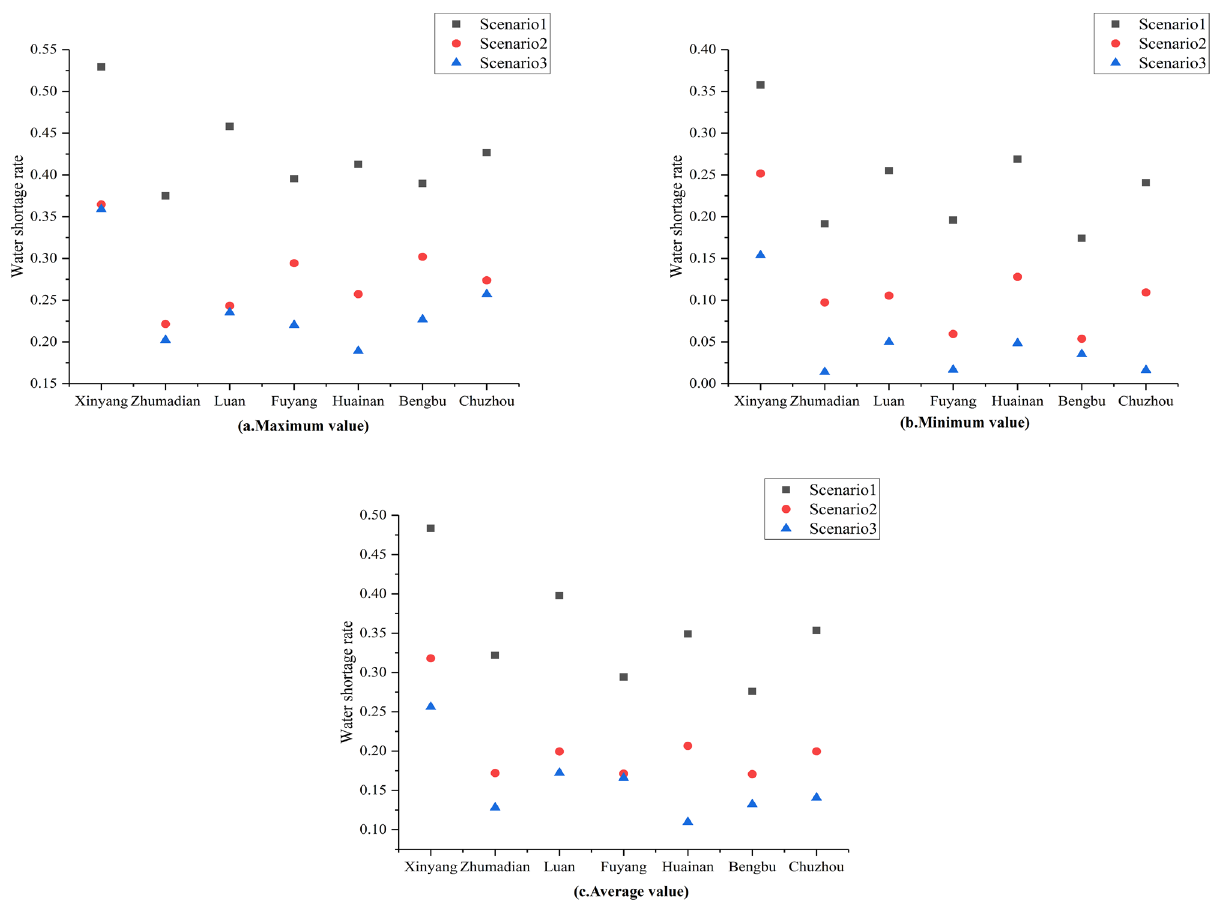
Figure 6. Water deficit rates for each city under three scenarios.